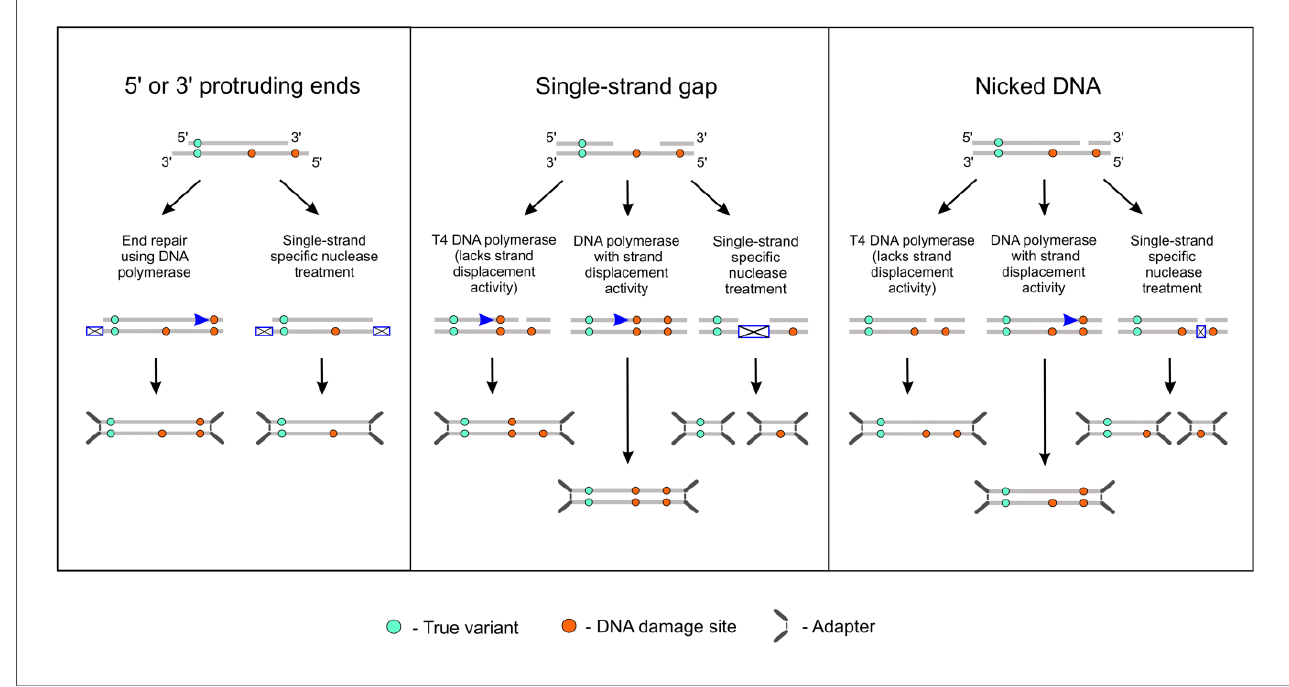
Figure 5. Use of DNA polymerases to repair DNA ends before NGS adapter ligation leads to the incorporation of errors in the synthesized complementary DNA strand, which is opposite to the damaged sites, when filling in 5 ′ -protruding ends or single-strand gaps, or when strand resynthesis is initiated from nicks in DNA. Substitution of DNA polymerases by single-strand-specific nucleases helps avoid this problem.